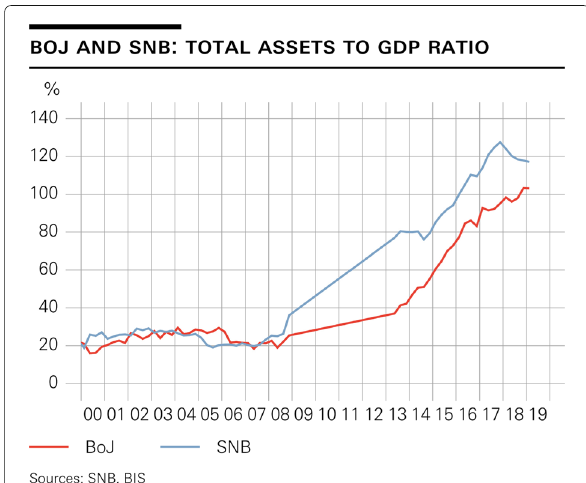
Fig. 1 BoJ and SNB: total assets to GDP